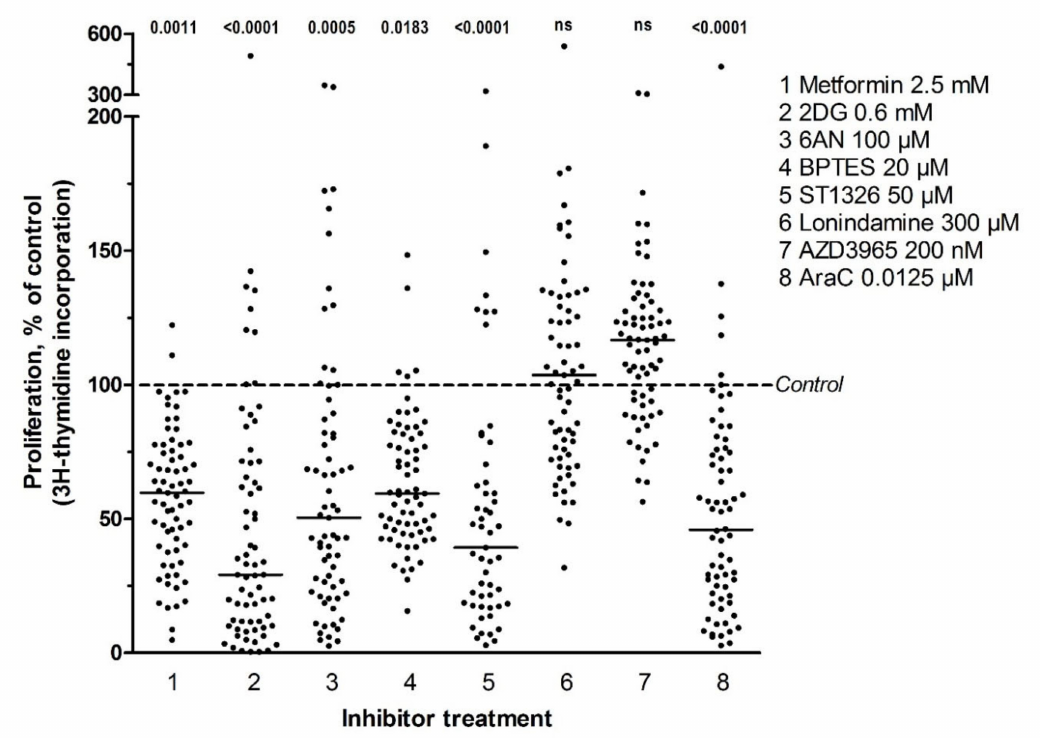
Figure 1. The e ff ect of treatment with metabolic inhibitors or AraC on AML cell proliferation. AML cells were cultured alone in medium supplemented with cytokines or treated with either metabolic inhibitors or AraC for 7 days before proliferation was measured using the [ 3 H]-thymidine incorporation assay. The inhibitor-free (untreated) controls were set to 100% (stippled line). Detectable proliferation was defined as > 1000 cpm, which was found for 69 out of the 81 control cultures; while 62 cultures were treated with ST1326 whereof 53 control cultures had detectable proliferation. Each dot represents the percent proliferation compared to respective control cultures (with detectable proliferation) for one patient, with the median value for all patients indicated by the solid line. Statistically significant e ff ects ( p -values) are shown at the top of the figure (ns, not significant). The Kruskal Wallis with Dunn’s post-hoc test was used for statistical